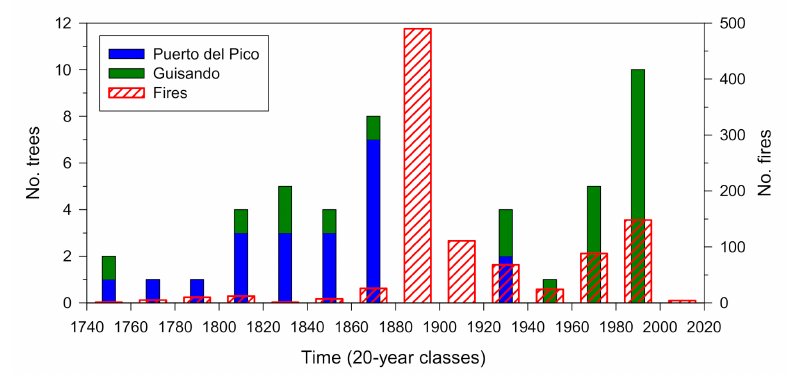
Figure 4. Scots pine recruitment (grey bars) reconstructed considering 20-year age classes in the two study forests (Puerto del Pico, Guisando) and historical records of fires (red bars with diag- onal lines). The number of fires corresponded to historical records of fire events in the Sierra de Gredos